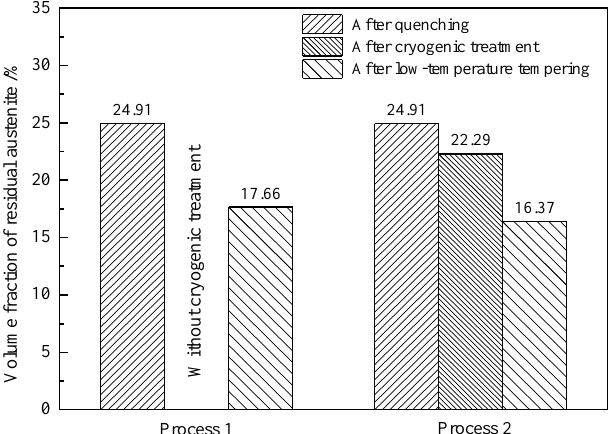
Figure 15. Volume fraction of the retained austenite in the carburized layer at a 0.3 mm depth.